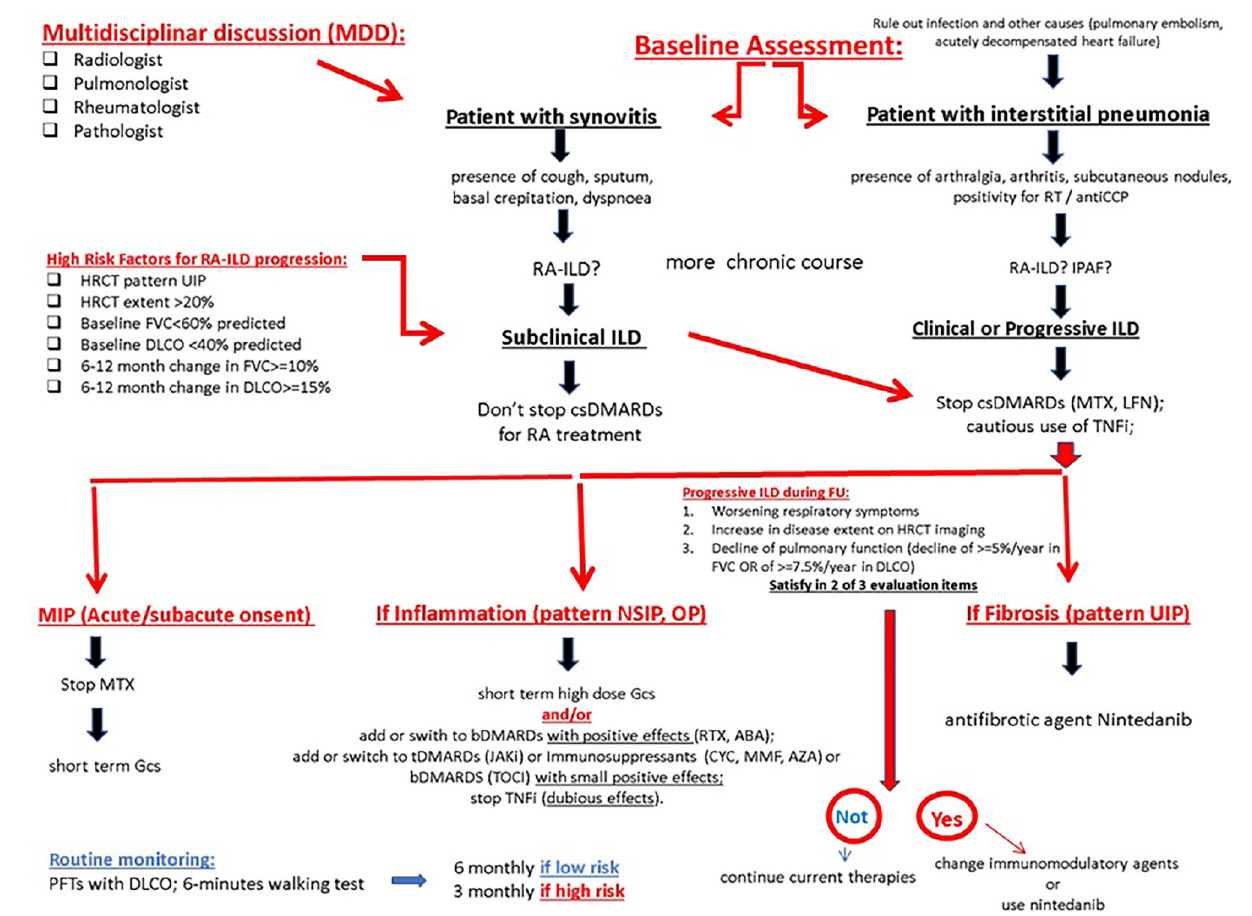
FIGURE 6 | The proposed algorithm for pulmonary symptoms in RA. ABA, abatacept; bDMARD, biological disease-modifying antirheumatic drug; csDMARD, conventional synthetic disease-modifying antirheumatic drug; ILD, interstitial lung disease; MTX, methotrexate; MTX-pneu, MTX-pneumonitis; RA, rheumatoid